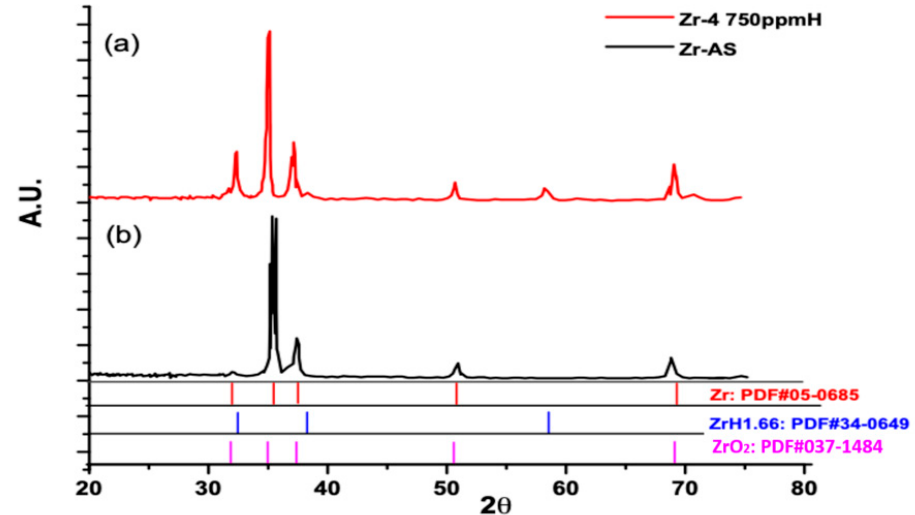
Figure 4. XRD characterization of ( a ) the unoxidized Zircaloy-4 specimen with 750 ppm of H and ( b ) the as-received Zircaloy-4 specimen.